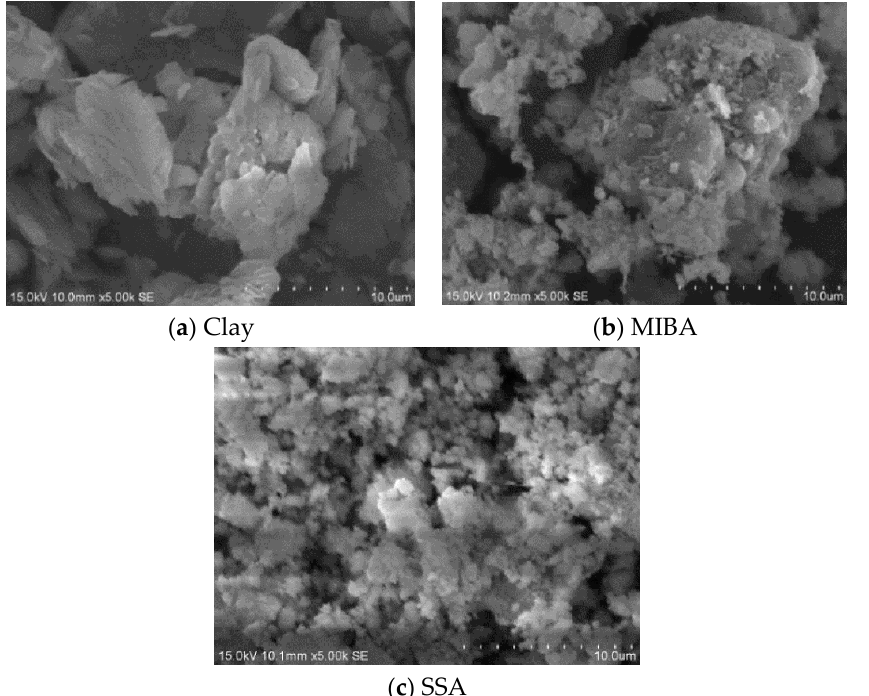
Figure 2. SEM images for the raw materials. ( a )Clay; ( b ) MIBA; ( c ) SSA.